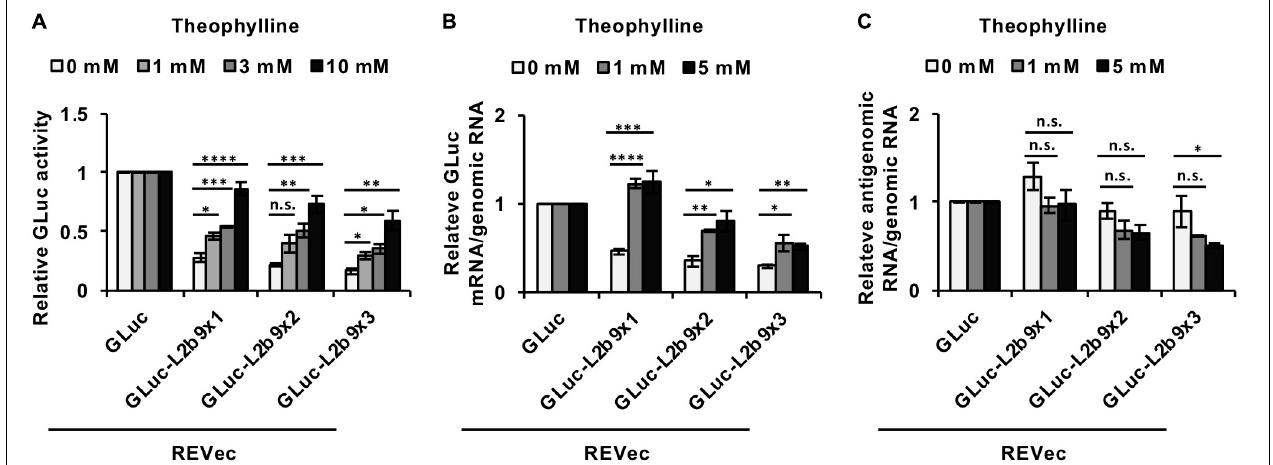
FIGURE 2 | Induction of transgene expression from REVec-GLuc-L2b9 by theophylline. (A) Relative luciferase activity after 24 h of treatment with 0, 1, 3, and 10 mM theophylline. Luciferase activities were normalized by the cell counts. (B,C) Quantification of RNA expression in REVec-GLuc-L2b9-infected Vero cells by qRT-PCR. The amounts of GLuc mRNA (B) and REVec antigenomic RNA (C) were measured and standardized against that of REVec genomic RNA. Values are expressed as the mean ± S.E. ∗ P < 0.05; ∗∗ P < 0.01; ∗∗∗ P < 0.005; ∗∗∗∗ P < 0.001 (Student’s t -test). At least three experiments were